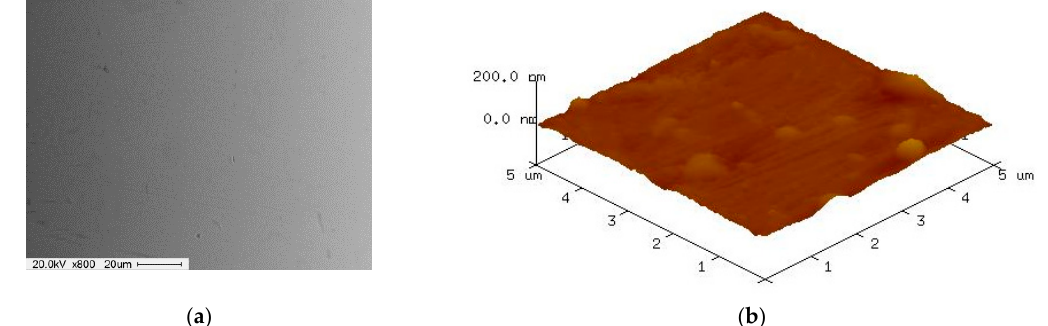
Figure 11. SEM and AFM surface images of 316L SUS wire after finishing by industrial magnetic abrasive tools (Ra: 0.05 µm, 1200 rpm, 10 Hz). ( a ) SEM surface image after finishing; ( b ) AFM surface image after finishing.